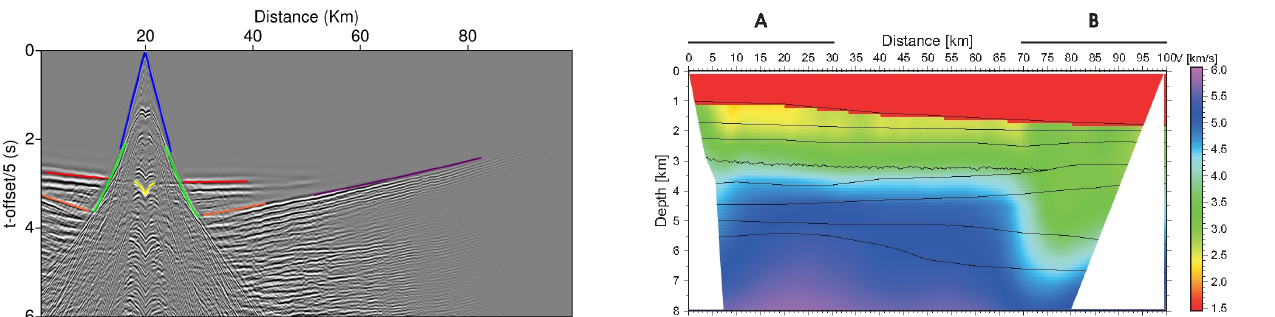
Fig. 4. Velocity model obtained using TTT package Trinks et al. (2005) after inverting refractions from the sediments over the basalt and reflections from the top of the basalt layer. Dashed lines represent layers from inversion and continous lines the theoretical layer interfaces. Note the coincidence between dashed line and continous line in the top of the basalt layer.The unresolved parts of the model at both ends of the transect are determined from forward modelling, ray tracing.